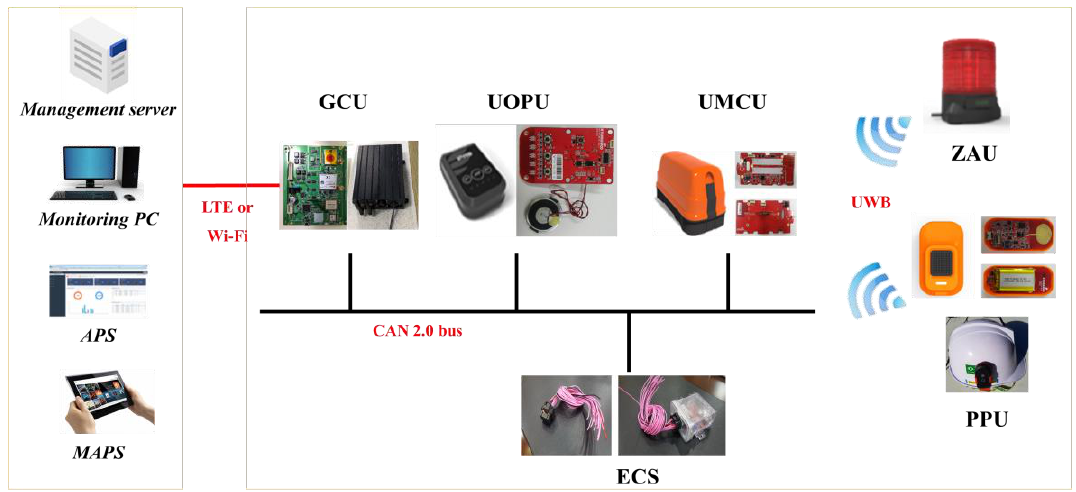
Figure 8. Hardware-software of UCAS and GRMS.